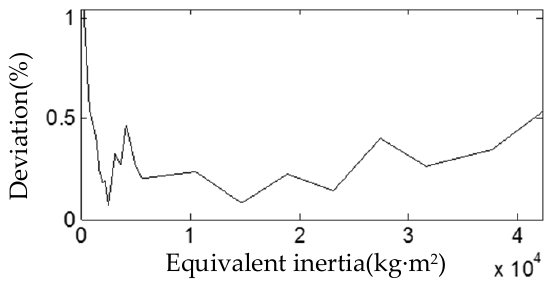
Figure 19. Deviation of standard inertia.